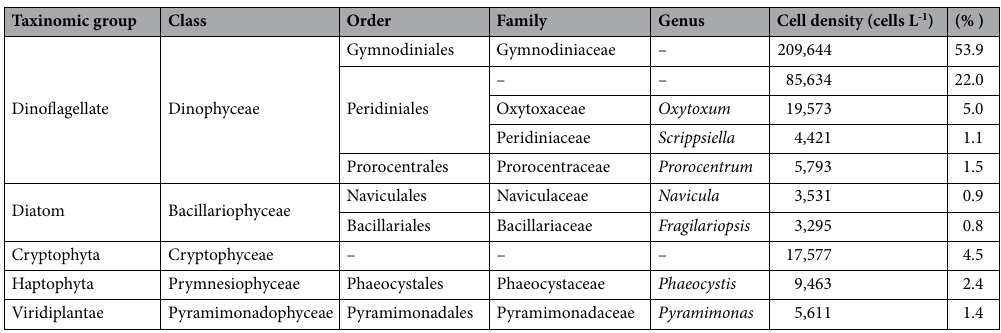
Table 3. Top 10 dominant phytoplankton taxa determined by light microscopy cell counting. “–” Indicates an unidentified taxonomic